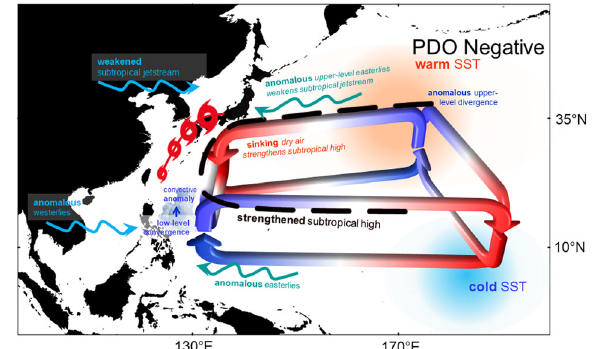
Fig. 7 In fl uence of the Paci fi c Decadal Oscillation to tropical cyclone (TC) variability in East Asia during the mature boreal autumn. The arrows indicate the direction of the circulation while the blue (red) color represents low (high) pressure regions. A negative PDO phase, characterized by warm sea surface tempera- ture (SST) in the North Paci fi c, is associated with increased rising motion, anomalous upper-level divergence, and anomalous upper- level easterlies. The risen upper air zonally fl ows westward and descends as dry air, which prompts the strengthening and westward extension of the Western North Paci fi c subtropical high (WNPSH). In addition, the said upper-level easterlies collides and stalls the upper- level westerlies associated with the subtropical jetstream, which results to further SST warming in the North Paci fi c. The weakened and stalled subtropical jetstream retreats northward allowing an expanded WNPSH. Meanwhile, the low-level convergence of anomalous westerlies and easterlies to the east of the Philippines prompts the rise of convective anomalies where it meridionally descends as dry air in the midlatitudes, which also strengthens the WNPSH. In the zonal direction, the risen air fl ows eastward and descends in the cold SST region in the eastern equatorial Paci fi c. In the meridional direction, the sunken dry air meridionally rises in the warm North Paci fi c SST. The strengthened WNPSH and northward- displaced jetstream result to a favorable steering environment that allows tropical cyclones to pass in the EA region.